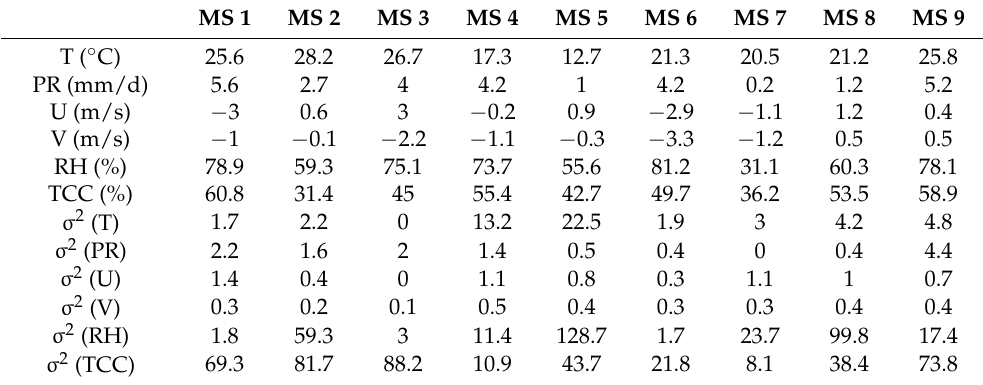
Table 3. The annual average and variance of the meteorological variables in nine MS